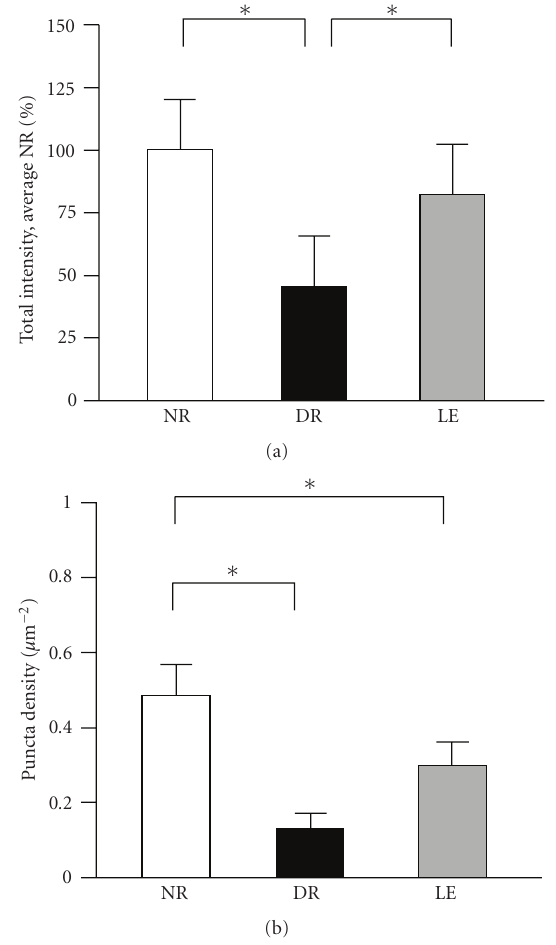
Figure 3: Two dimensional analysis of total GAD65 intensity and puncta density. (a) The total GAD65 staining intensity in a single focal plane was decreased in the DR group when compared to NR and LE (normalized total GAD65 intensity: NR = 100 ± 9.3%, n = 20 sections from 4 mice; DR = 45 ± 6.8% of average NR, n = 17 sections from 4 mice; LE = 82 ± 15.7% of average NR, n = 18 sections from 4 mice; ANOVA: F (2,52) = 7 . 341, P < . 01). Asterisks: P < . 05 using Fisher’s PLSD posthoc analysis. (b) The measurement of GAD65 puncta per area decreased on average in the DR group, but did not show a significant reversal with a subsequent light exposure (GAD65 puncta number per μ m 2 : NR = 0.48 ± 0.08, n = 20 sections from 4 mice; DR = 0.13 ± 0.04, n = 17 sections from 4 mice; LE = 0.30 ± 0.06, n = 18 sections from 4 mice; ANOVA: F (2,52) = 6 . 030, P < . 01). Asterisks: P < . 03 using Fisher’s PLSD posthoc